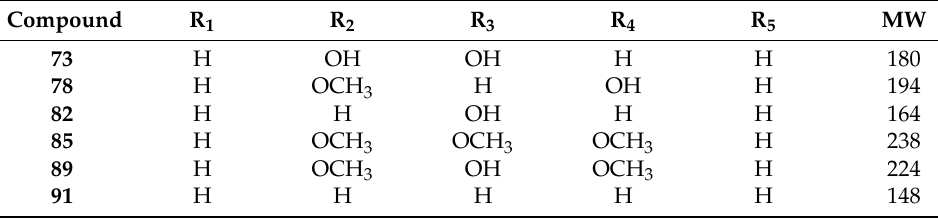
Table 9. Benzoic acid